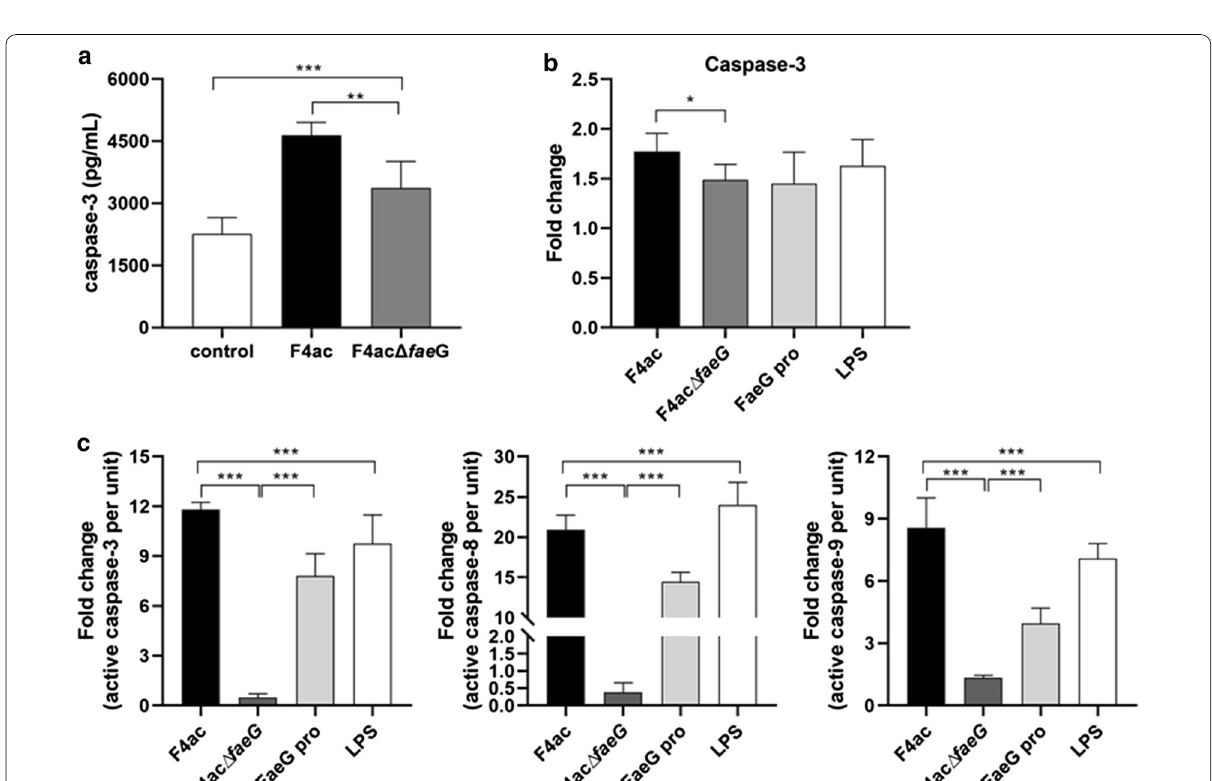
Fig. 2 The change of protein expression with different treatments in IPEC-J2 cells. Data are presented as mean independent experiments and normalized to gapdh expression. The asterisk indicates a statistically significant differences, * p < 0.05, ** p < 0.01